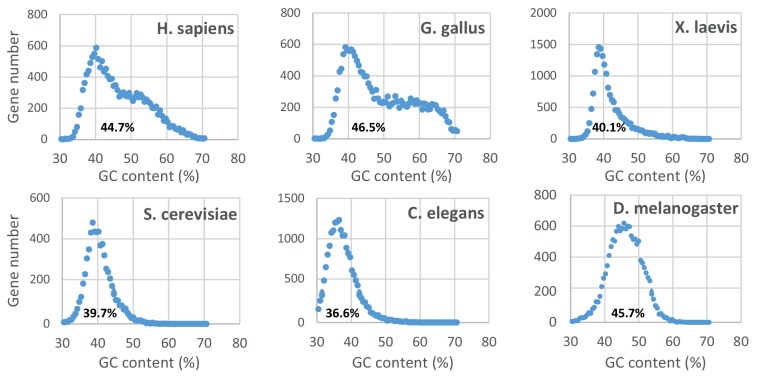
Distribution of the gene GC content in various eukaryotic genomes.The graphs were constructed as in Figure 1—figure supplement 1F. The median value for each genome is indicated below.